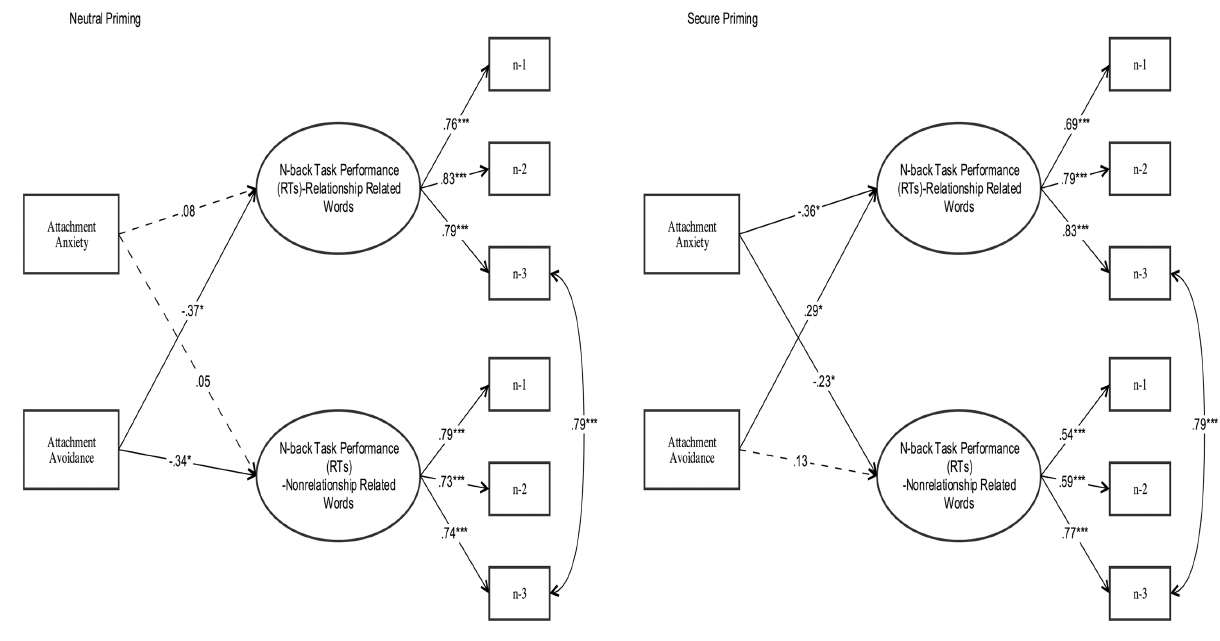
Fig 3. Attachment dimensions predicting the processing